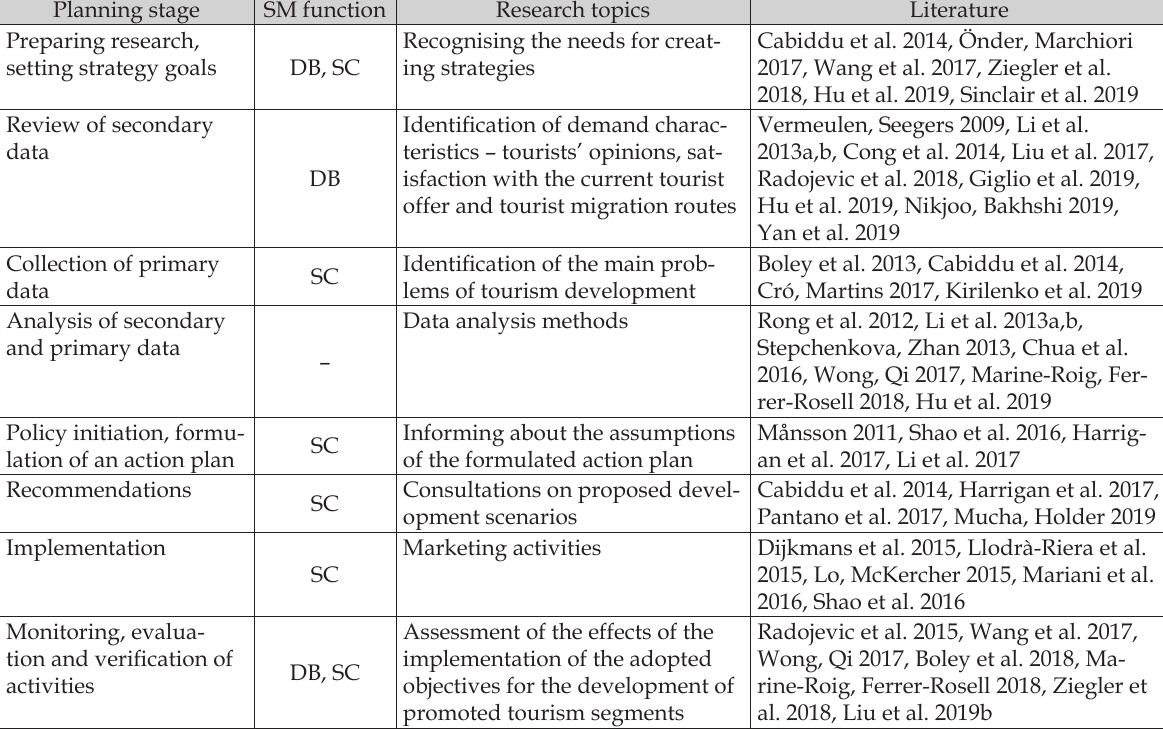
Table 2. SM as a source of data and communication tools in tourism development